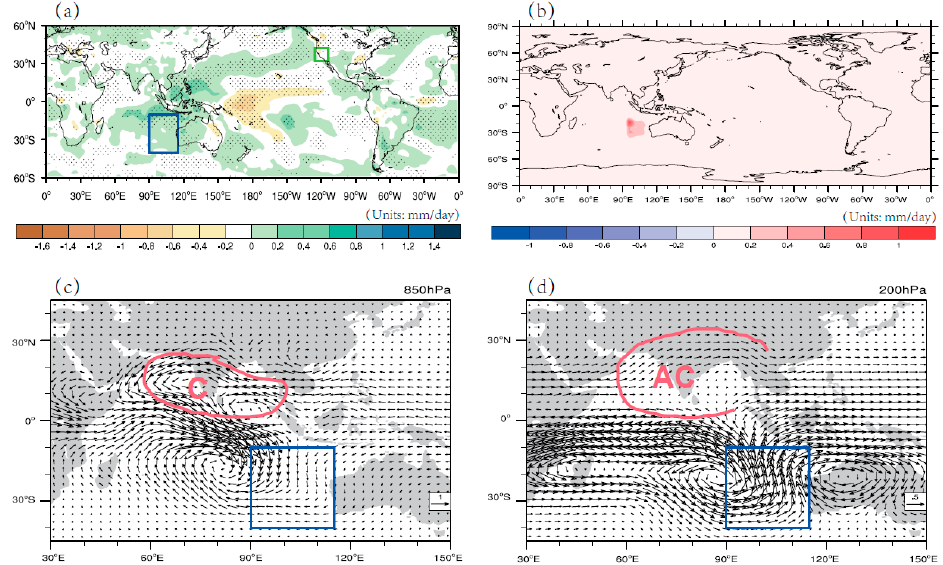
Figure 8. ( a ) Precipitation (mm/day) in winter regressed to the box-averaged SST (blue box). The green box represents the selected California area. Areas with dots exceed the 90% confidence level. ( b ) Diabatic heating anomaly pattern introduced into the AGCM experiment. Atmospheric response (m/s) at 850 hPa ( c ) and 200 hPa ( d ) in the model. “C” and “AC” represent the anomalous cyclone and anticyclone induced.